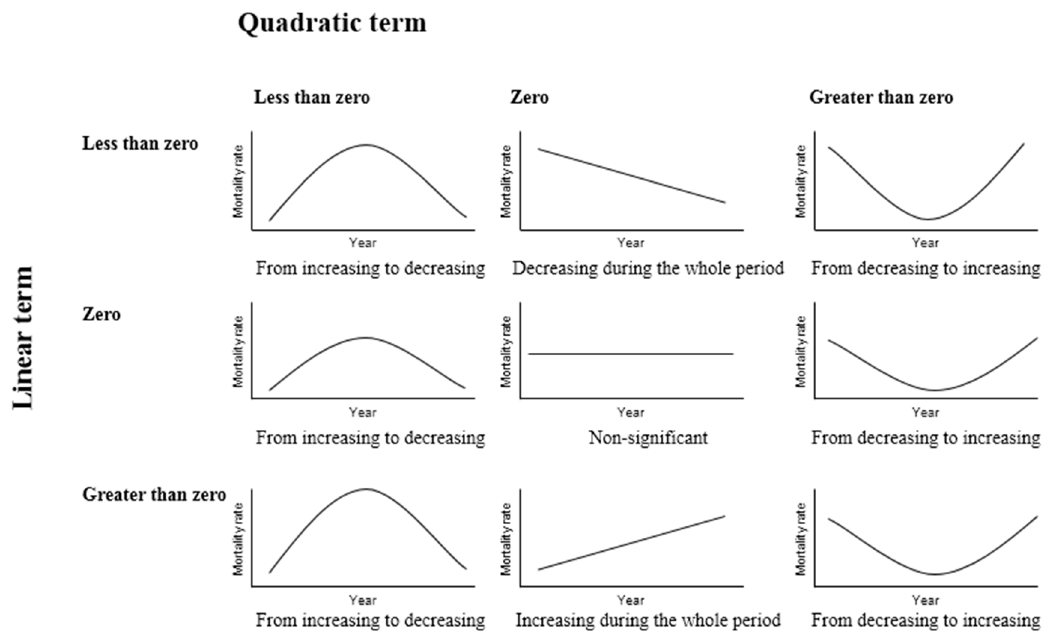
Figure 2. Possible graphical forms of the age-specific mortality trend for each municipality of Andalusia (southern Spain) according to the value of the linear and the quadratic term of its time function.